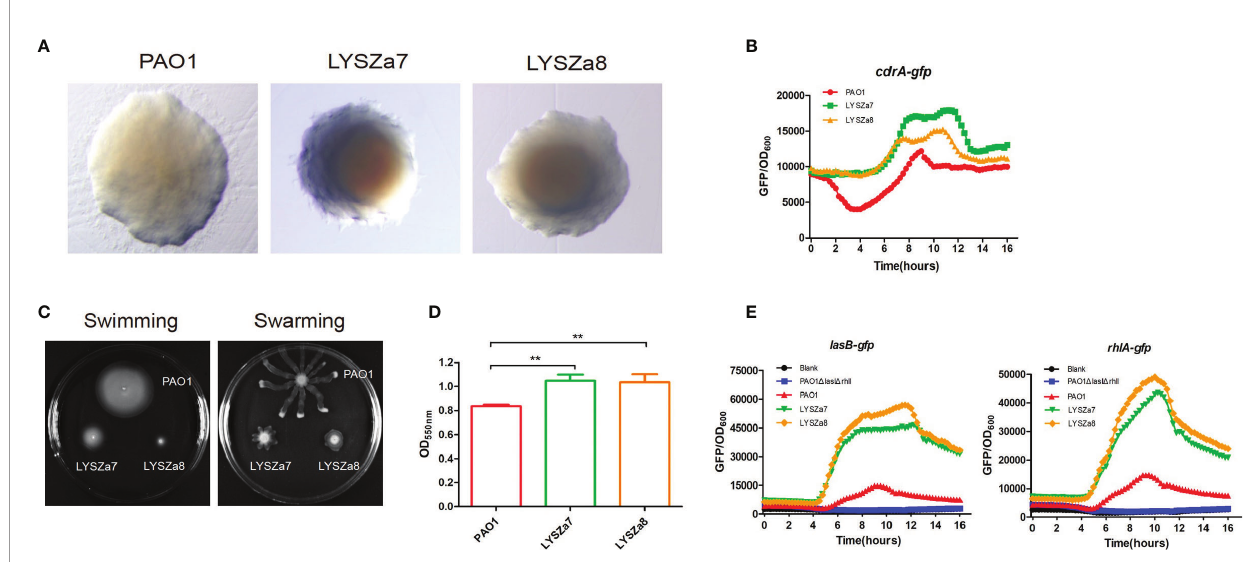
FIGURE 1 | Phenotypic tests. (A) Colony morphologies of P. aeruginosa PAO1, LYSZa7 and LYSZa8; (B) Cyclic-di-GMP levels in P. aeruginosa PAO1, LYSZa7 and LYSZa8 measured by cdrA ::gfp reporter assay; (C) Swimming motility (left plate) and swarming motility(right plate) of P. aeruginosa PAO1, LYSZa7 and LYSZa8; (D) Bio fi lm formation of P. aeruginosa PAO1, LYSZa7, and LYSZa8 quanti fi ed by CV staining, **p-value <0.05; (E) las and rhl quorum sensing expression measured by PAO1 D lasI D rhlI / P lasB::gfp and PAO1 D lasI D rhlI / P rhlA::gfp reporter strains.